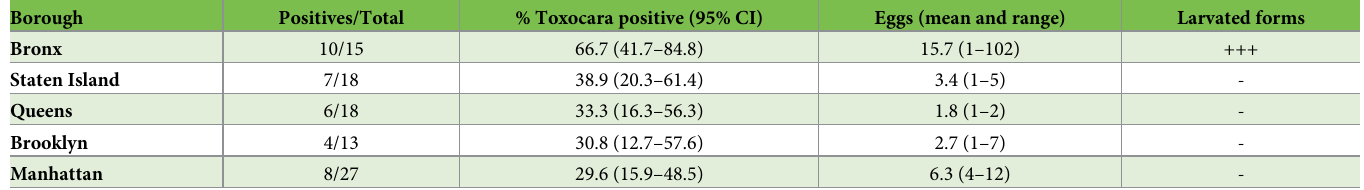
Table 1. Prevalence of Toxocara sp. including the presence of larval forms in specimens collected from sites in each NYC borough. Larvated, infectious Toxocara sp. were only found in the Bronx, the borough that had the highest prevalence of Toxocara contamination.